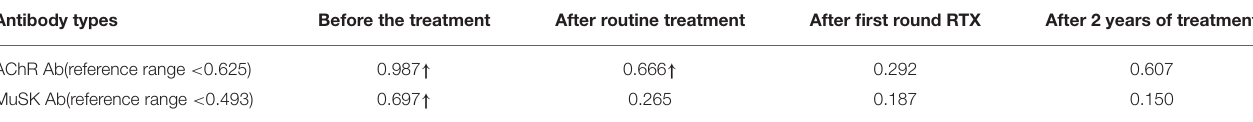
TABLE 1 | Comparison of antibody levels at different treatment stages in this case. Antibody